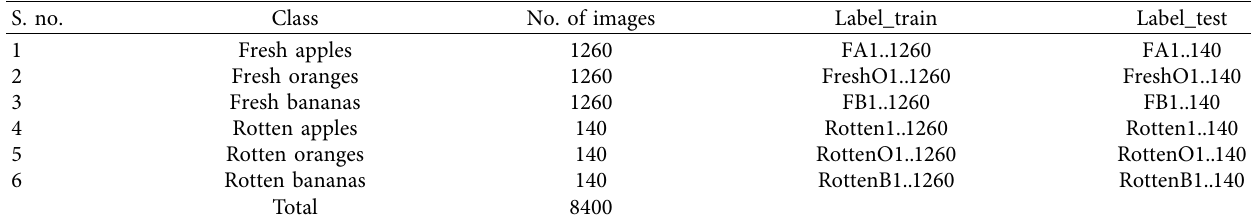
Table 1: Number of images in each class for training.